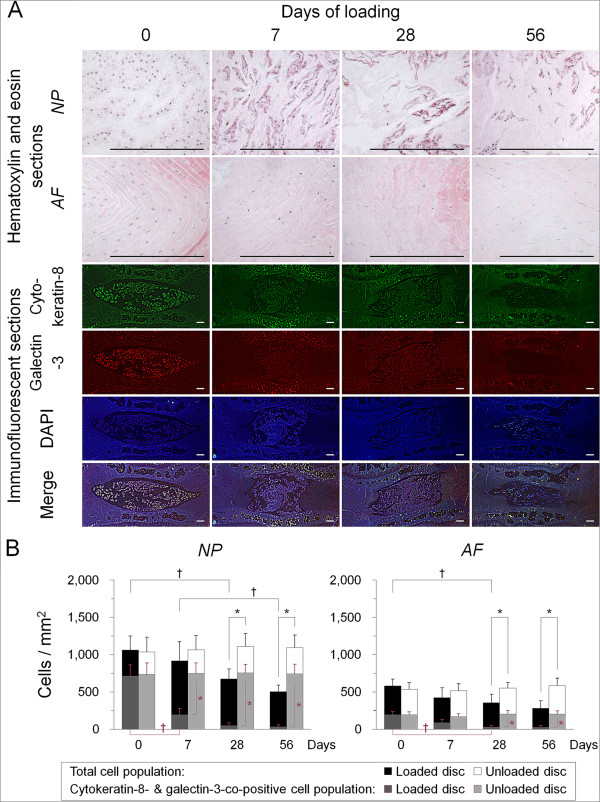
Sustained static compression induces a disproportionately large decrease in intervertebral disc cells with a notochordal phenotype. (A) Representative hematoxylin and eosin sections and immunofluorescent sections for cytokeratin-8, galectin-3, 4′,6-diamidino-2-phenylindole (DAPI), and merged signals in the loaded disc nucleus pulposus (NP) and annulus fibrosus (AF) at 0, 7, 28, and 56 days of loading (bars, 200 μm). (B) Changes in the population of DAPI-positive total cells and cytokeratin-8- and galectin-3-co-positive cells, identified as notochordal cells, in the NP and AF at 0, 7, 28, and 56 days of loading. Data are mean ± standard deviation (n = 6). Two-way analysis of variance with the Tukey-Kramer post hoc test was used. *P < 0.05 when compared between loaded and unloaded conditions. †P < 0.05 when compared between different time points.